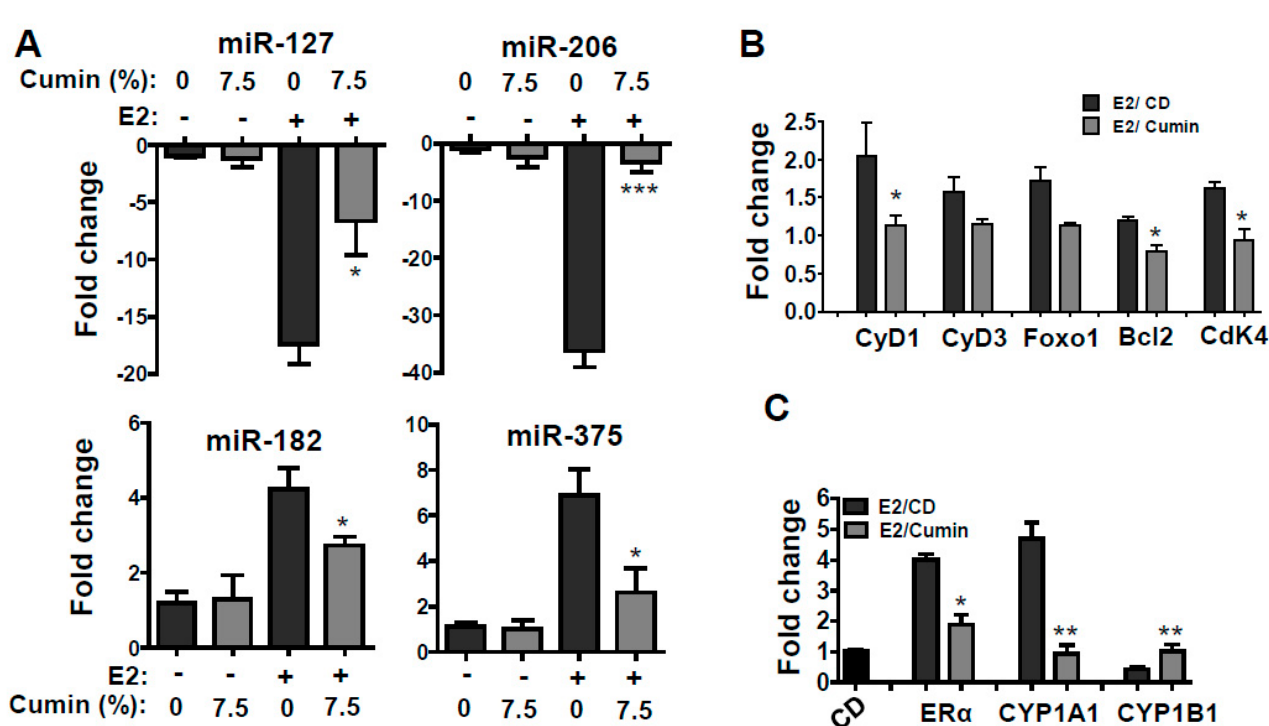
Figure 5. Effect of dietary cumin seed powder (7.5%, w / w ) on select microRNAs ( A ), their downstream targets ( B ) and 17ß-estradiol (E2)-related markers ( C ) in E2-mediated mammary tumorigenesis. Total RNA was used to assess relative gene expression using the differences in normalized Ct ( ∆∆ Ct) method after normalization to 18s rRNA. Fold changes were calculated by 2- ∆∆ Ct. Experiments were performed in triplicate for each data point. Data represent mean ± SD of fold change in mRNA expression relative to the untreated control fed with AIN93M control diet (CD) of five animals. Statistical significance was analyzed by Student’s t test where * p < 0.05; ** p < 0.01; *** p < 0.001.